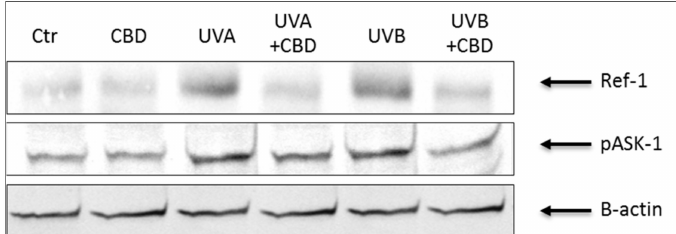
Figure 3. The influence of cannabidiol (CBD) on Ref-1 and phospho-ASK-1 (pThr845) levels in keratinocytes exposed to UVA (30 J / cm 2 ) and UVB (60 mJ / cm 2 )